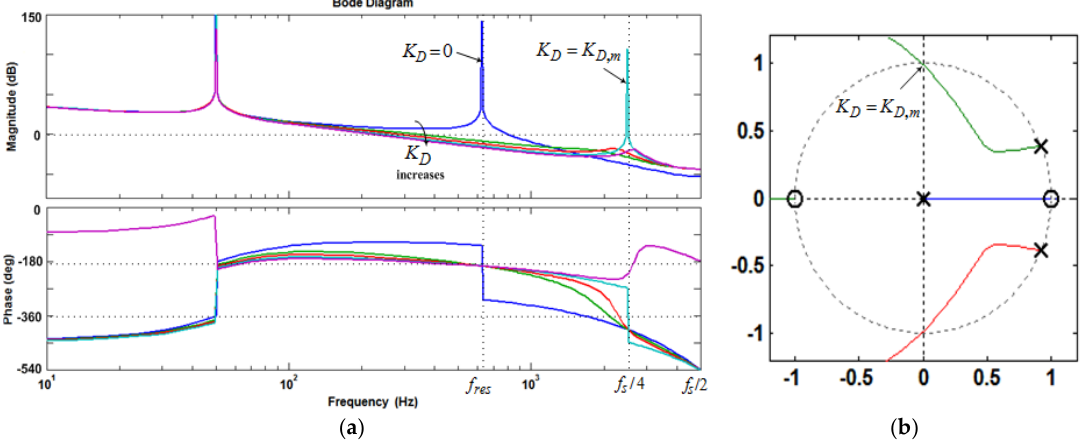
Figure 23. Stability analysis of the CCF AD with reduced computation delay. ( a ) Bode plotsof the open-loop gain; and ( b ) root loci of the inner proportional CCF only. ( f res < f s /6; C f = 36 μ F; K p = 0.0261; K i = 3.0769).